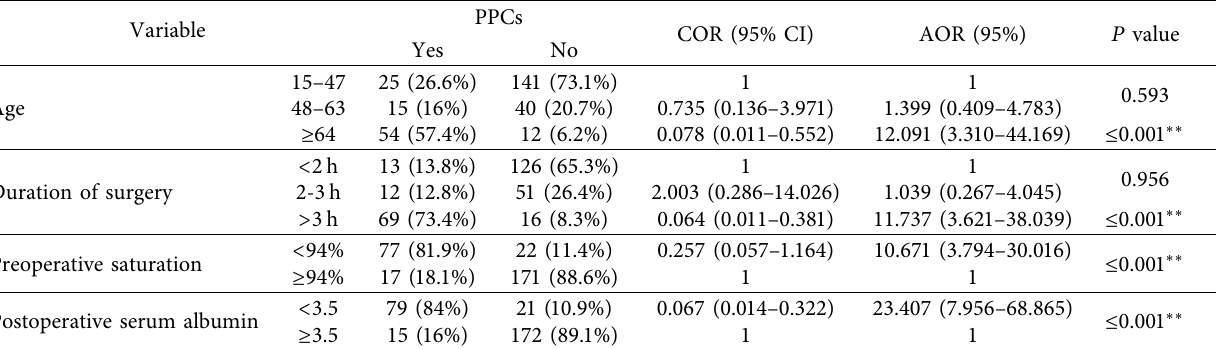
Table 5: Factors associated with postoperative pulmonary complication in abdominal surgical patients at public hospitals, Ethiopia.